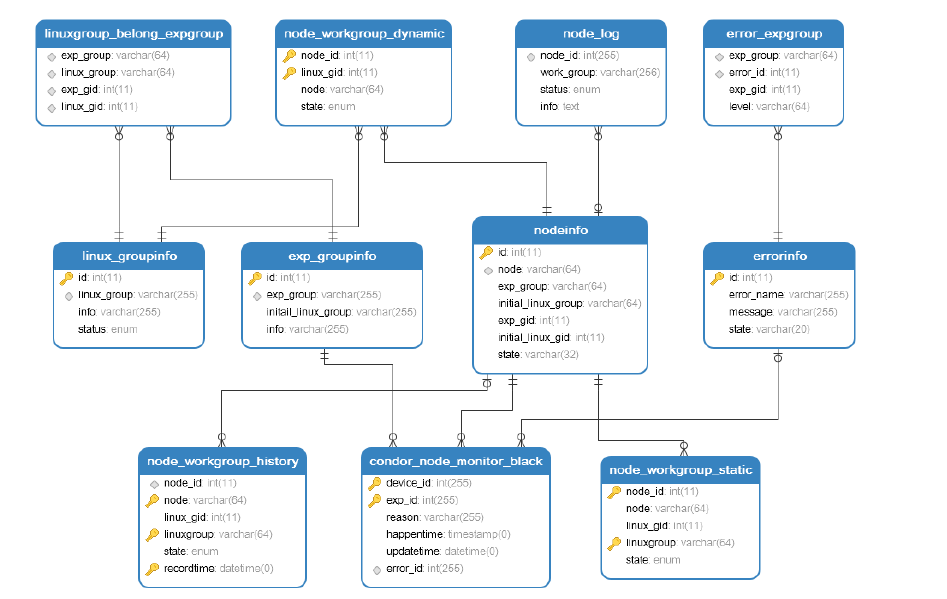
Fig. 2. E-R diagram of the resource